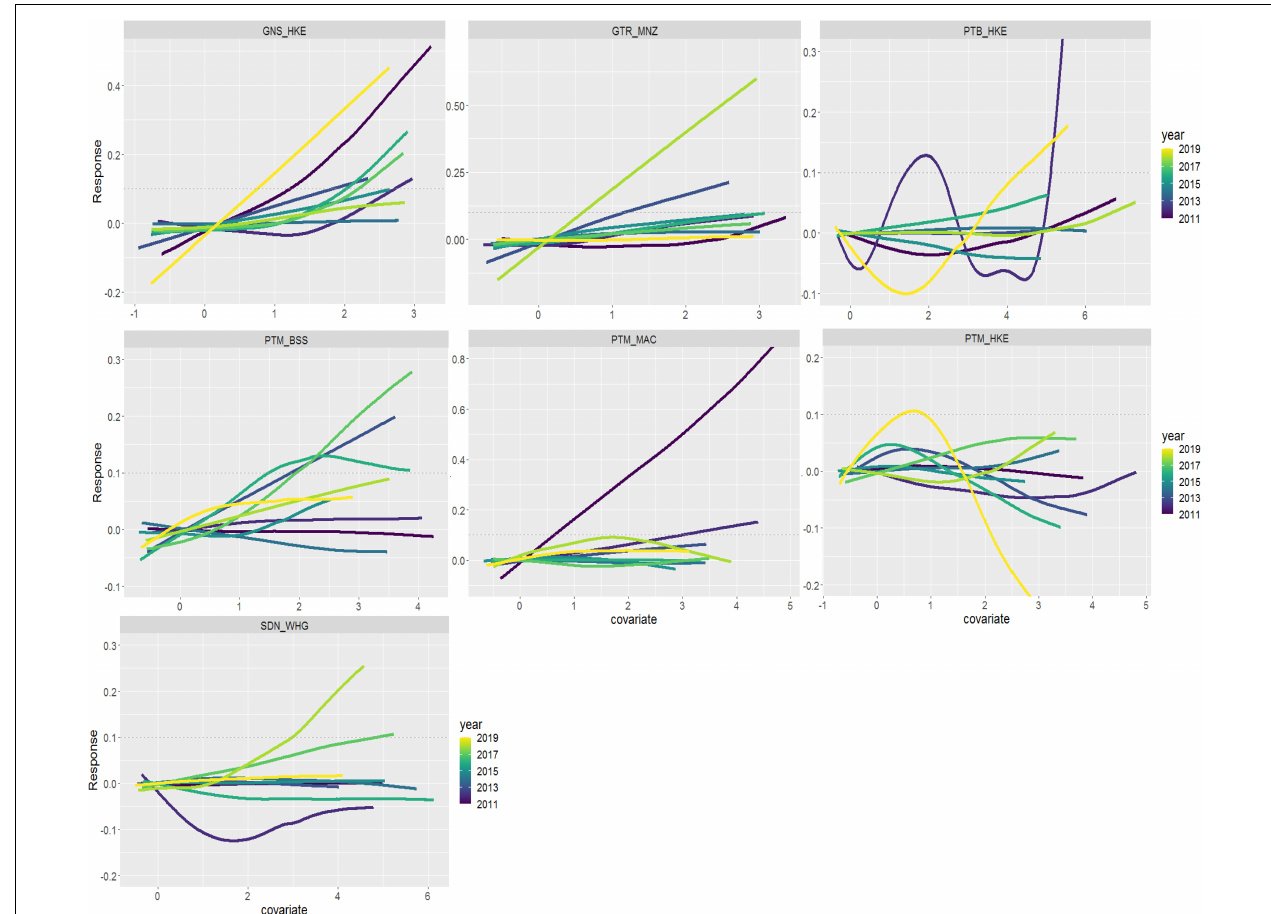
FIGURE 7 | Functional relationships between the origin of bycaught common dolphins and fishing effort in ICES subareas 27.8.a and 27.8.b for French fleets according to caught species: gillnetters catching hake (GNS_HKE), trammel netters catching anglerfish (GTR_MNZ), bottom pair trawlers catching hake (PTB_HKE), midwater pair trawlers catching sea bass (PTM_BSS), midwater pair trawlers catching mackerel (PTM_MAC), Danish seiners catching whiting (SDN_WHG). ICES, International Council for the Exploration of the